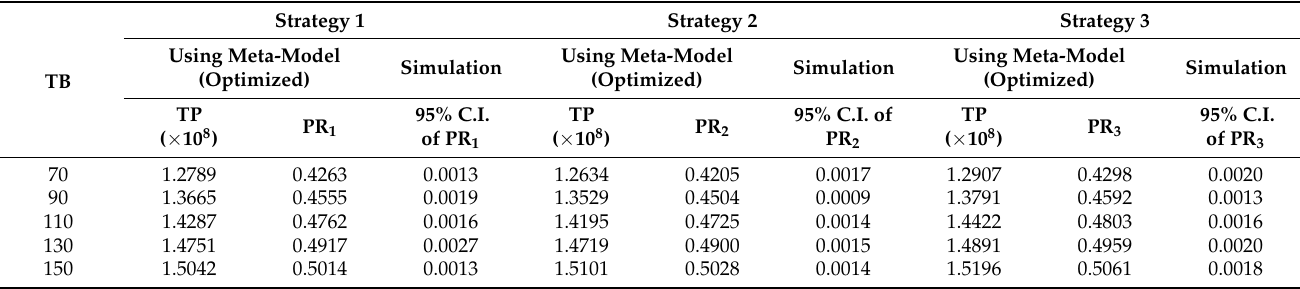
Figure 6. Comparison of total profits among reconfiguration strategies (product-mix = 30%). Table 11. Optimized results using meta-model and confidence intervals from simulation (product-mix = 30%).